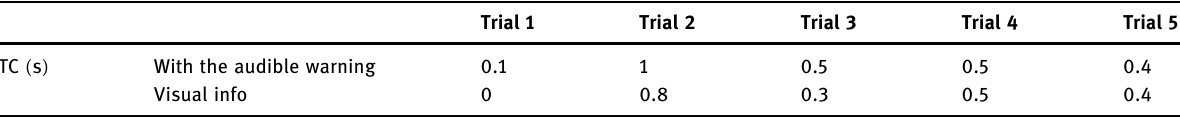
Table 7: Time to a collision when a warning was issued in individual trials for scenario